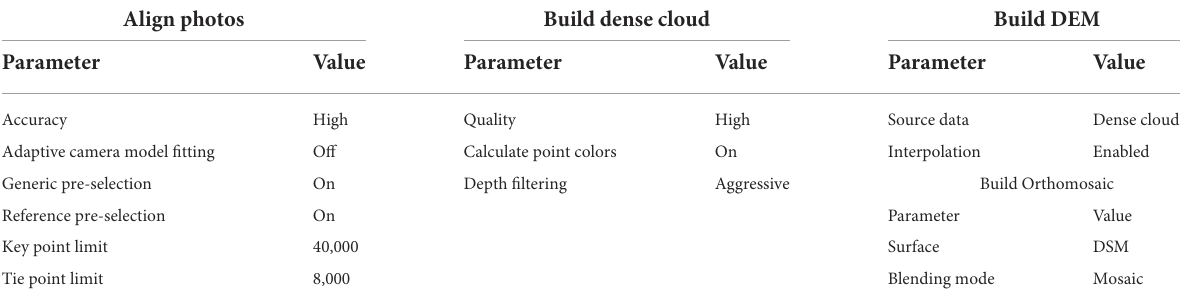
TABLE 1 Values of parameters used in agisoft